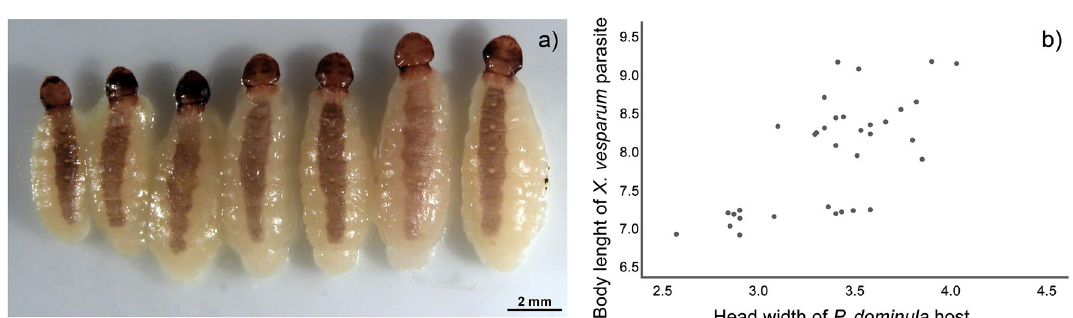
Figure 4. Size of X. vesparum females. ( a ) X. vesparum females dissected after the winter diapause (n = 7) sorted by size. ( b ) Correlation plot between host and parasite body size (n = 34). The head width of the wasps, ranging from 2.57 to 4.03 mm, is positively correlated with the length of the parasite ( p <